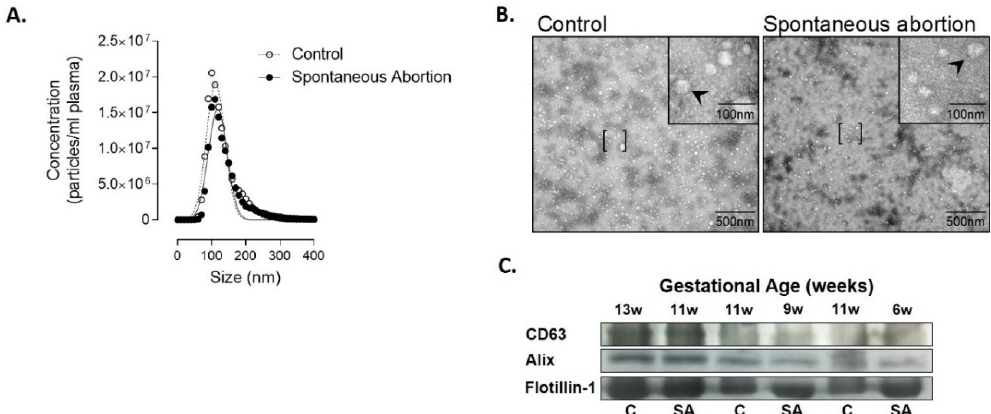
0.8240 Abbreviations: SD, standard deviation (percentile 25–75); HDL, high density lipoprotein; LDL, low density lipoprotein; HbA1c, glycated hemoglobin; AST, aspartate aminotransferase; ALT, alanine aminotransferase; ALP, alkaline phosphatase; SHBG, sex hormone-binding globulin. 3.2. Characterization and Quantification of Extracellular Vesicles in Plasma In order to identify a biomarker for early detection of spontaneous abortion, we first characterized EVs isolated from plasma of patients with spontaneous abortion and normal